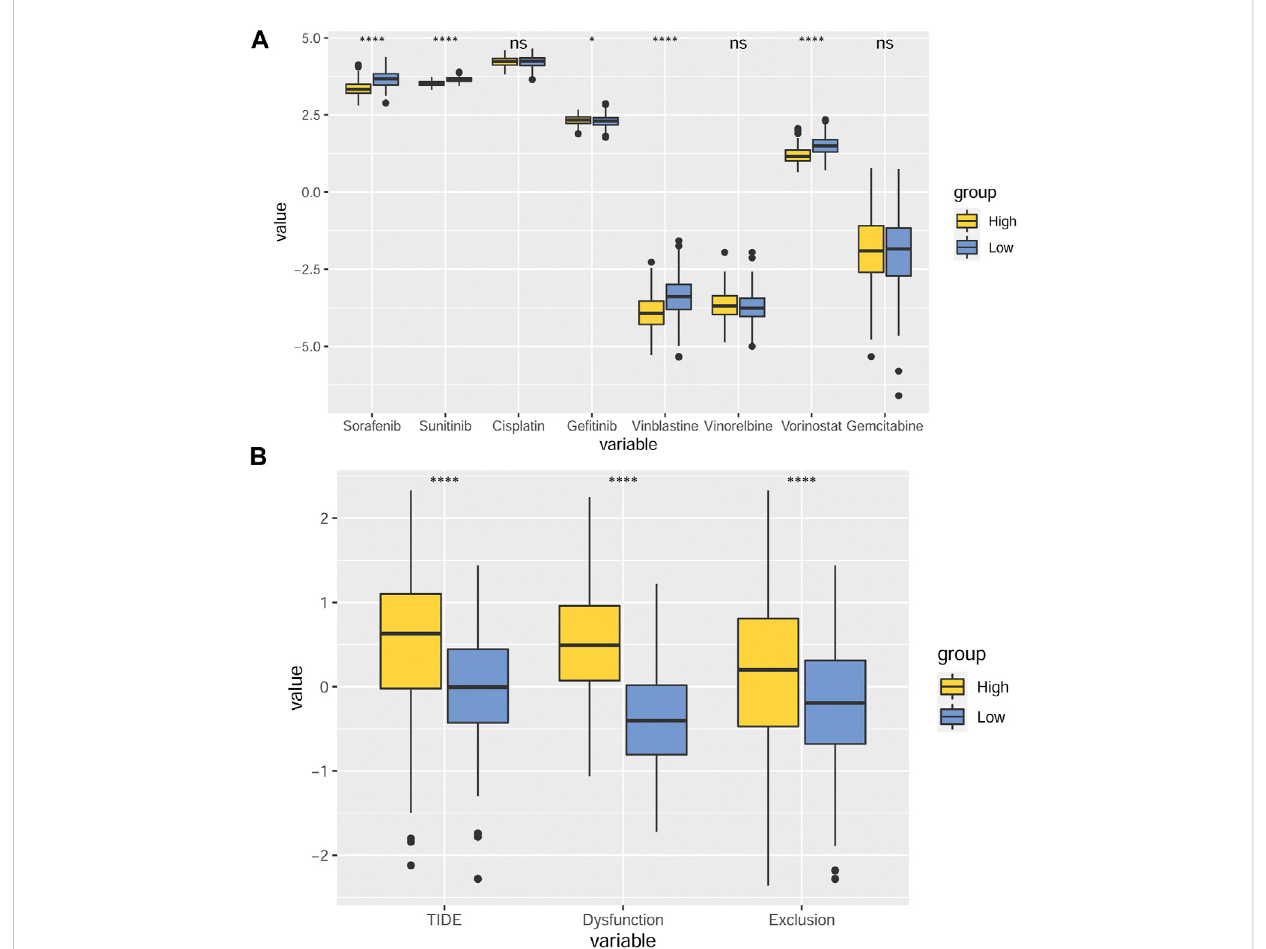
FIGURE 7 MMP scores and drug IC50 inference (A) Box plots depicting the differences in predicted IC50 values for sorafenib, sunitinib, cisplatin, ge fi tinib, vincristine, vorinostat, and gemcitabine between the different MMP scoring groups. (B) Differences in TIDE scores, immune dysfunction, and rejection